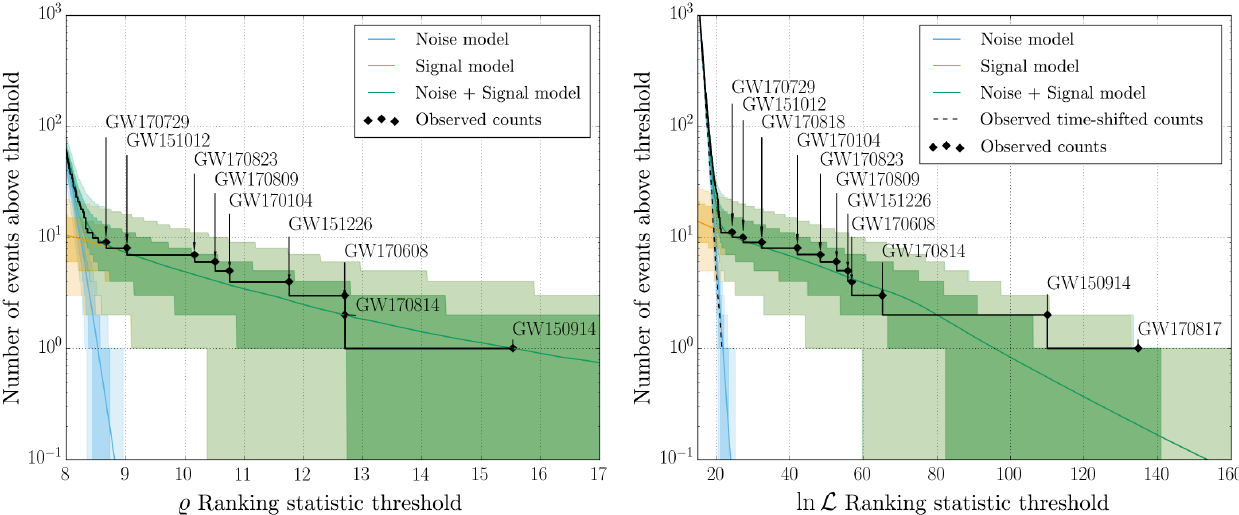
FIG. 11. Astrophysical signal and terrestrial noise event models compared with results for the matched-filter searches, PyCBC (left) and GstLAL (right), versus the respective search ’ s ranking statistic: ϱ for PyCBC [73] and ln L for GstLAL [9,82]. These ranking statistics are not the same as the SNRs reported in Table I; see citations for details. For each panel, the solid colored lines show the median estimated rate ( “ model ” ) of signal, noise, or signal plus noise events above a given ranking statistic threshold, while shaded regions show the estimated model uncertainties on the combined and individual models at 68% and 95% confidence. The observed number of events above the ranking statistic threshold is indicated by the black line, with confidently detected events (Sec. IV B) labeled. The PyCBC signal model and observed events are restricted to events with masses compatible with a BBH, with a chirp mass > 4 . 35 M ⊙ (so that BNS candidate events including GW170817 are not plotted); the GstLAL signal model includes all events, with the signal counts summed over the three astrophysical categories BNS, NSBH, and BBH. The different ranking statistic used in the PyCBC and GstLAL searches lead to differently shaped signal models. The black dashed line in the GstLAL plot shows a realization of the cumulative counts in time-shifted data, reinforcing its consistency with the noise